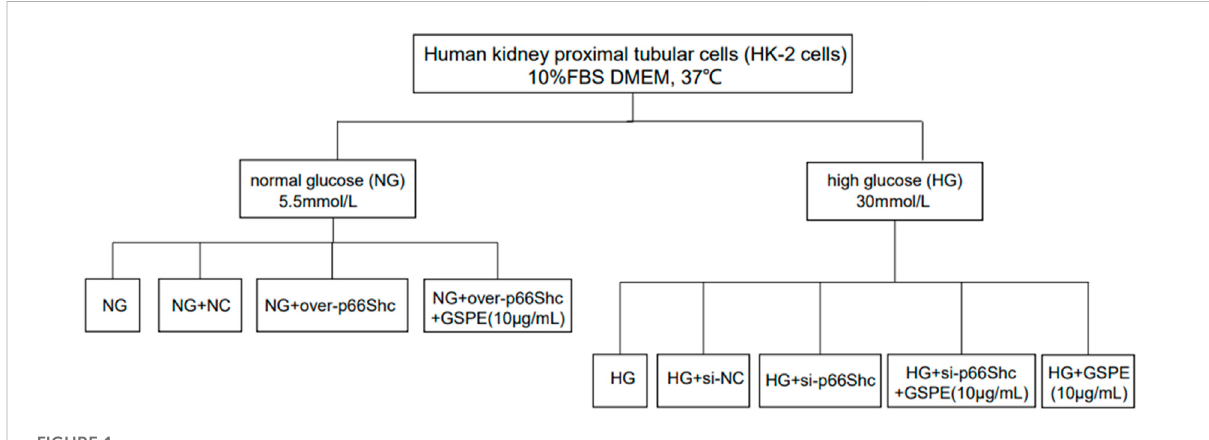
FIGURE 1 The grouping fl ow